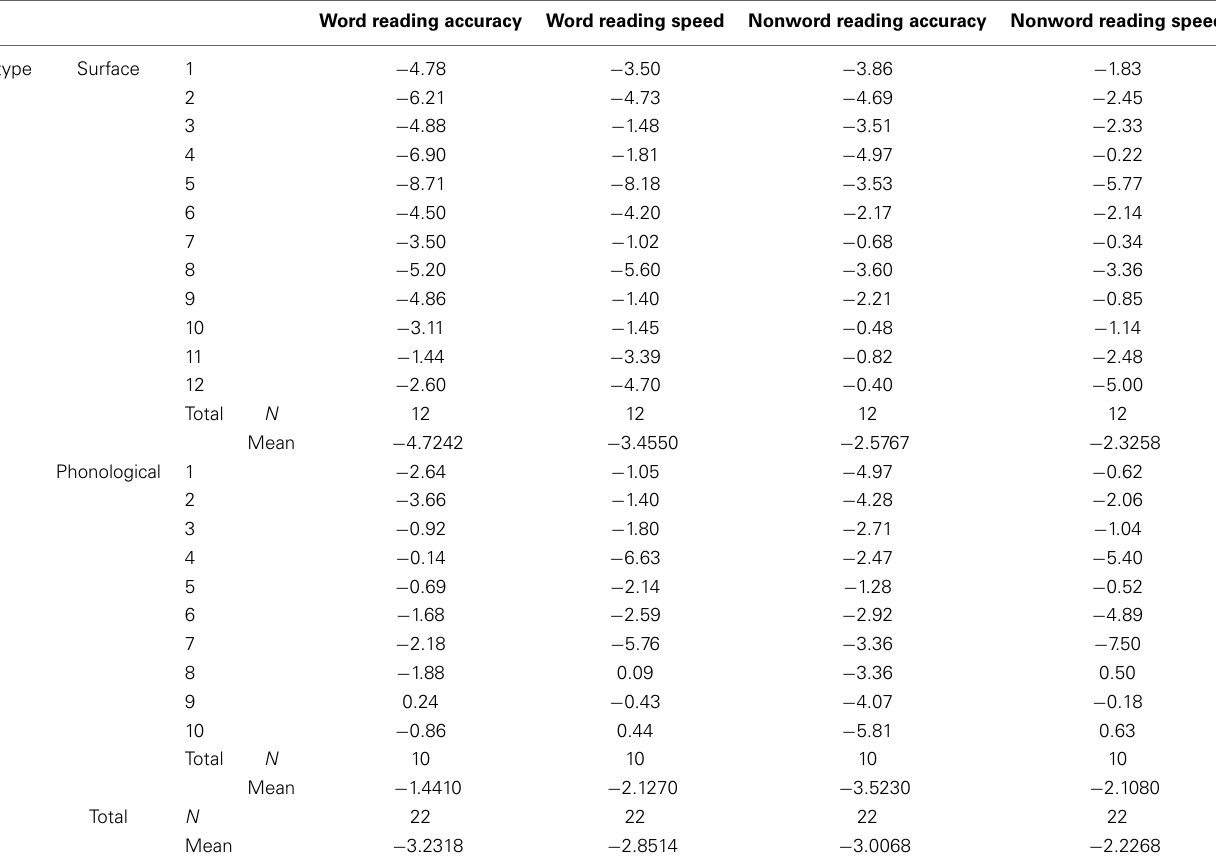
Table 2 | z-scores for word and nonword reading for each participant (DD